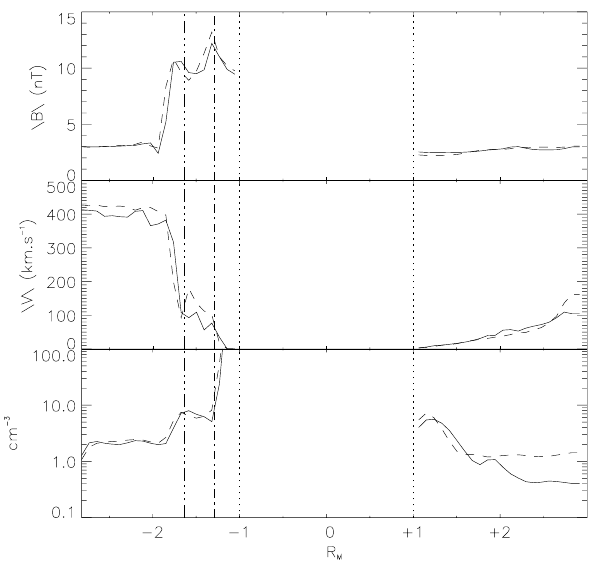
Fig. 2. Variations of the intensity of the magnetic field, of the bulk velocity, and of the total number density of the multi-species plasma along the Sun–Mars line. Values for solar minimum (maximum) conditions are shown by the solid (dashed) curves. The vertical dashed-dotted lines indicate the average subsolar positions of the bow shock (BS) and Magnetic Pile-up Boundary (MPB) deduced from the MGS